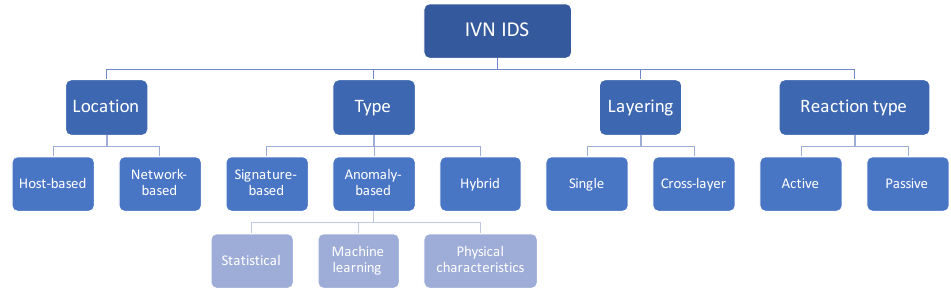
Figure 2. Proposed unified IVN IDS